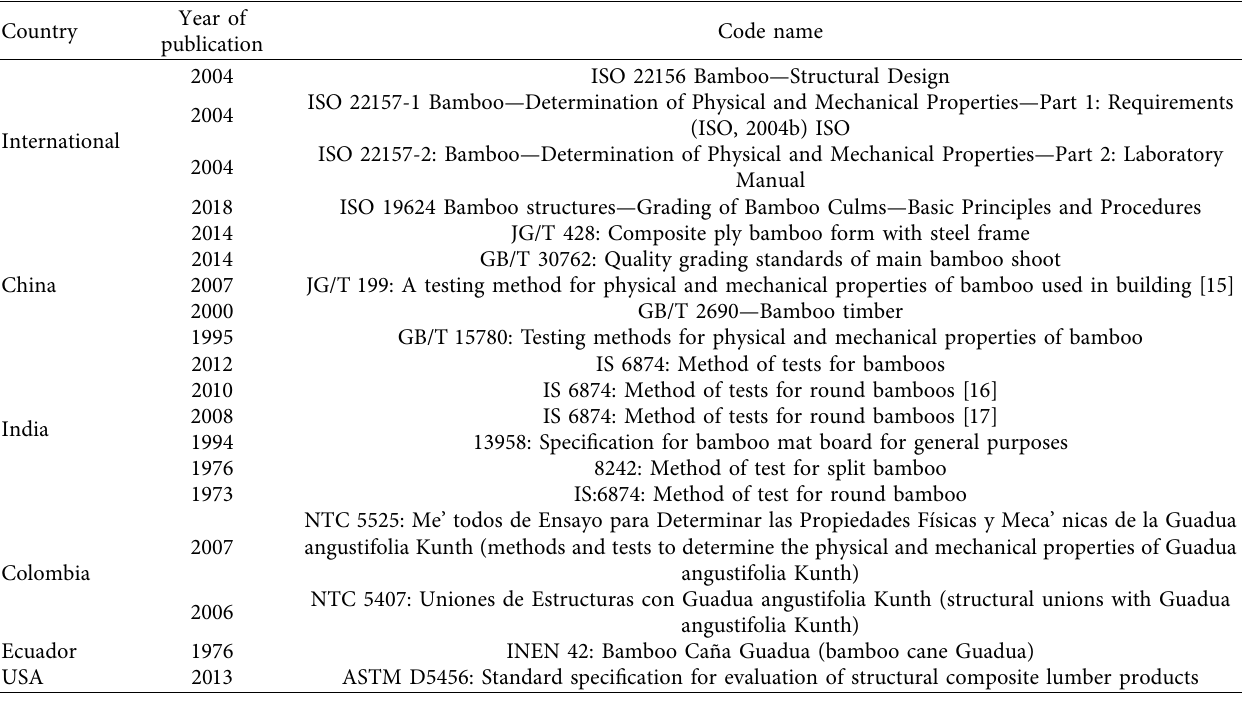
Table 2: Standards for bamboo structural